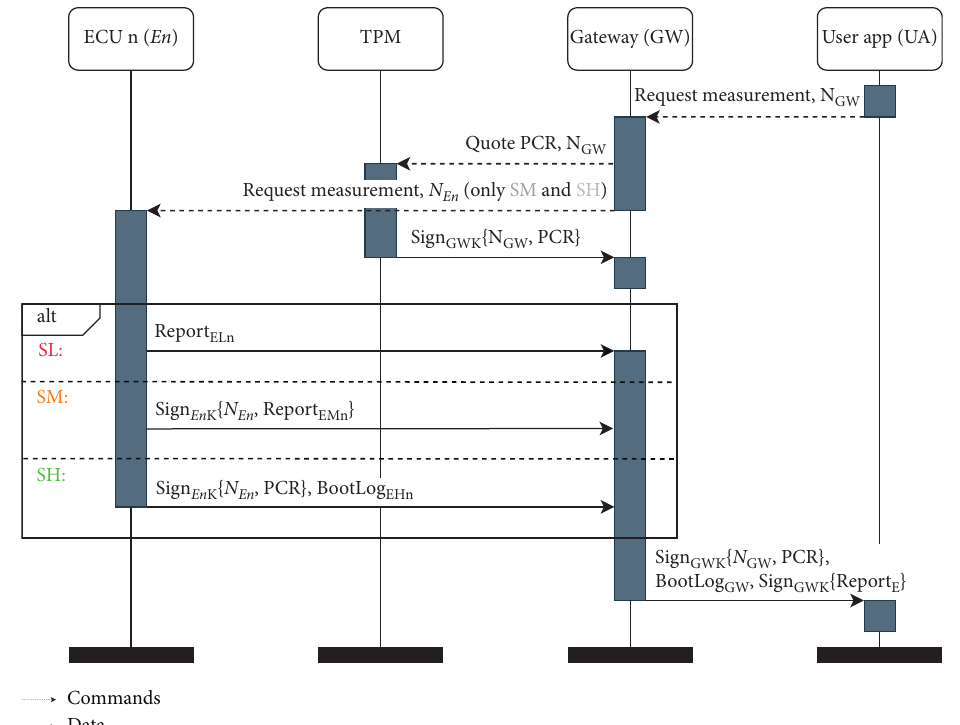
Figure 6: Message flow diagram for taking a measurement of the vehicle, triggered by the user application.